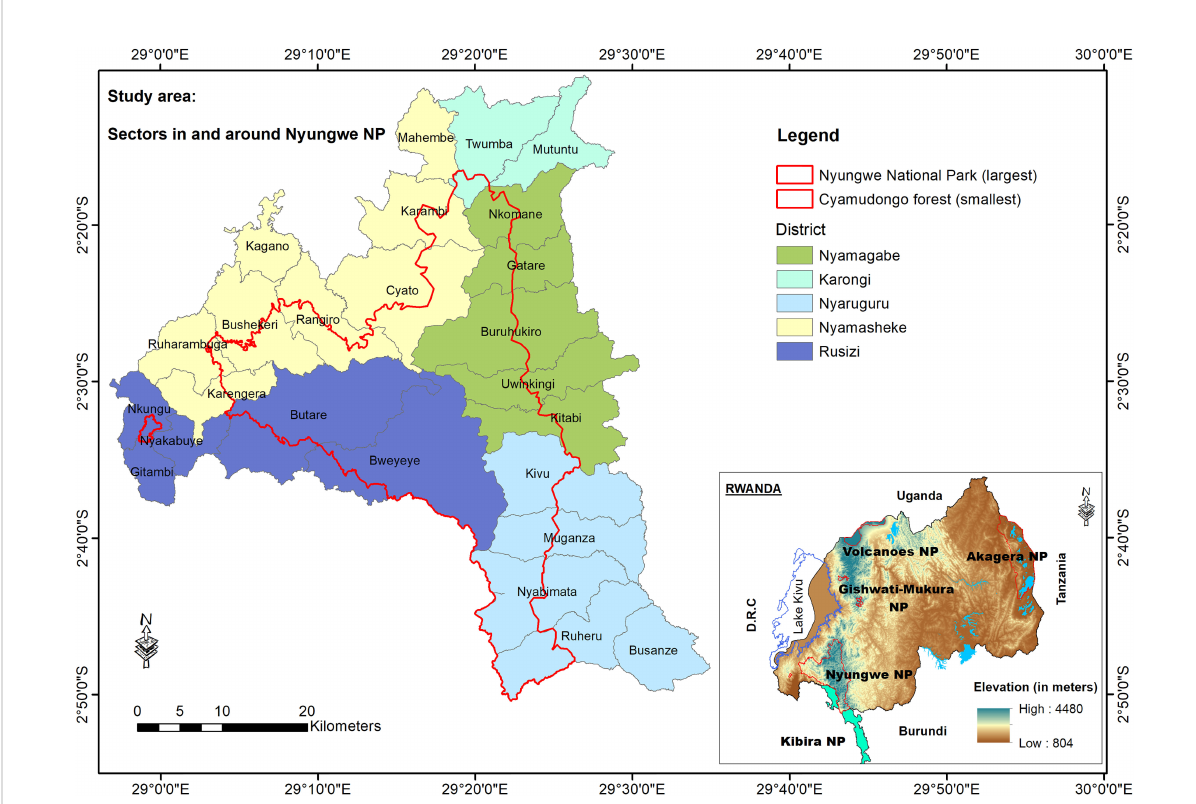
FIGURE 1 Administrative boundaries of the area of interest: 25 sectors within fi ve districts bordering Nyungwe National Park are the primary spatial unit of quantitative analysis in this study. Cells are the administrative unit within sectors in Rwanda. Only 24 sectors are targeted for tourism revenue sharing (TRS), but we also considered the sector of Kagano, which received TRS funding only